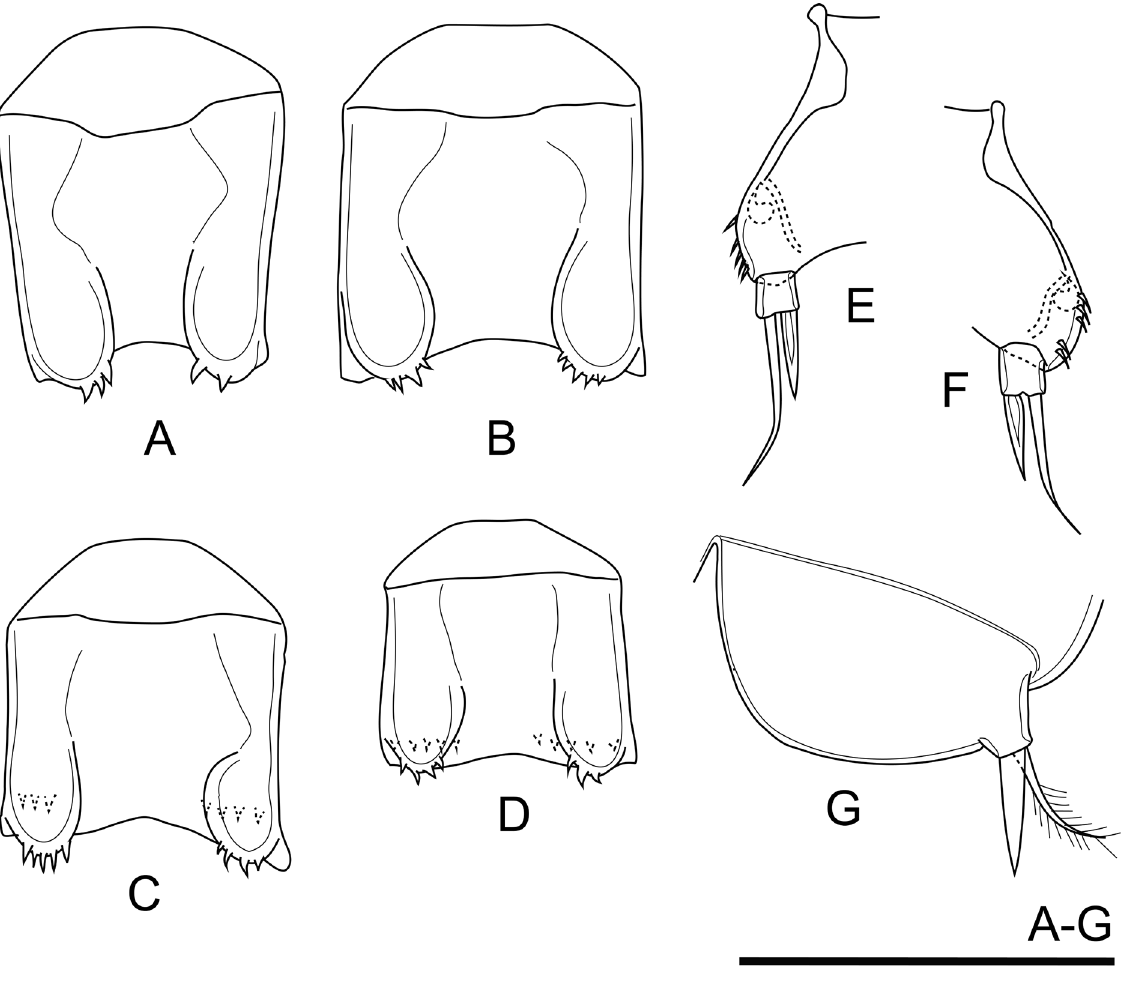
Fig. 15. Metacyclops brancelji sp. nov., paratype, ♂ (A−D; ZMB 34231 slide No. 5127) and allotype, ♂ (E−G; ZMB 34231 slide No. 5125). A−D . Intercoxal sclerites of P1, P2, P3 and P4, respectively, frontal view. E−F . Right and left P5, respectively, ventral view. G . P6, ventral view. In C − D, the spinule row is on the caudal surface of intercoxal sclerite. Scale bar = 50